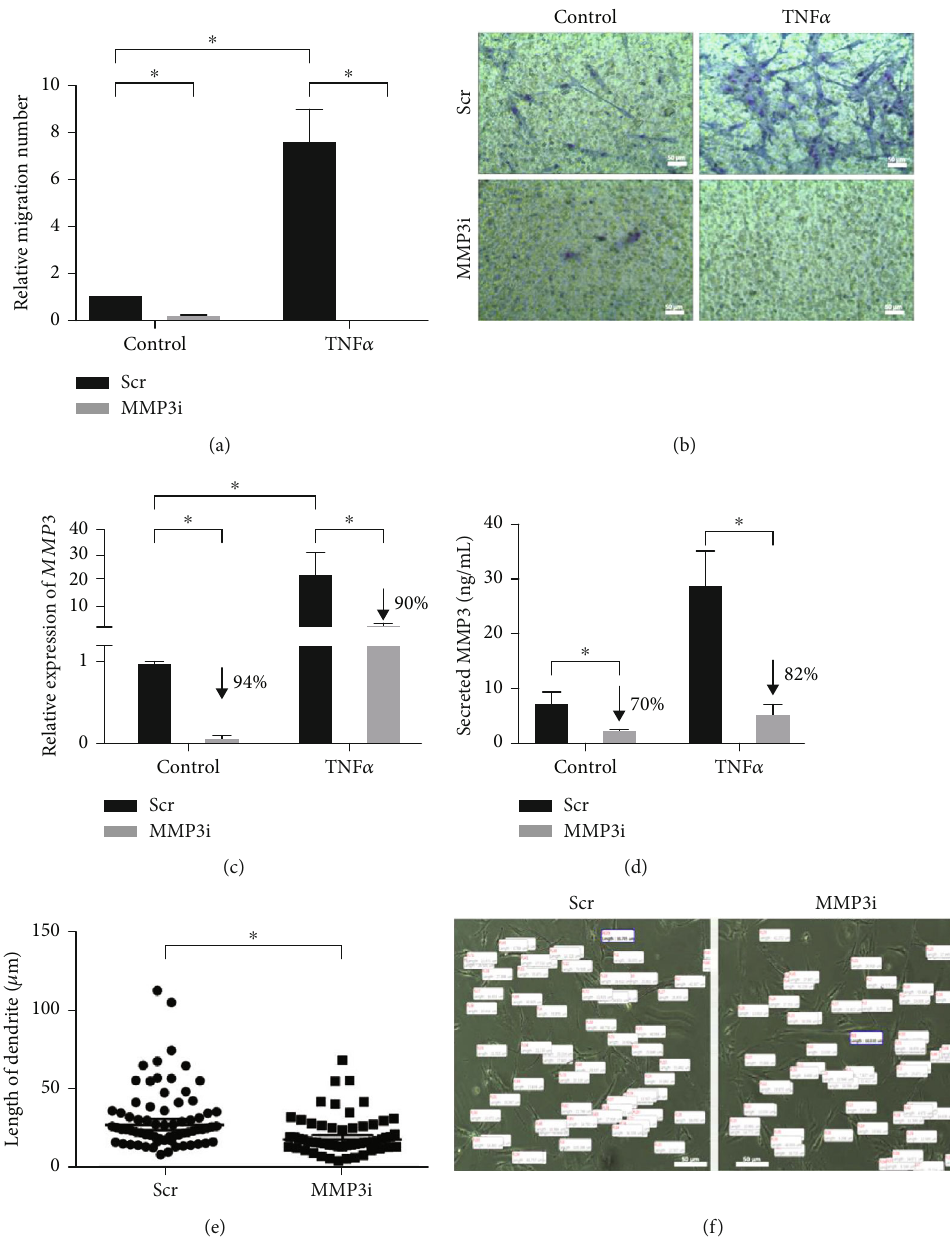
Figure 3: FDCLC migration is induced by TNF α and is dependent on MMP3 expression. FDCLCs were transfected with either the MMP3 siRNA (MMP3i) or a scrambled-RNA-negative control (Scr). The cells were then treated with TNF α , and a migration assay was performed using A Matrigel-coated Transwell system. (a) Disruption of MMP3 expression drastically suppresses TNF α -induced FDCLC migration. The Transwell membranes were stained with hematoxylin and eosin, and the migrated cells that attached to the undersurface of the membrane were counted in 3 di ff erent fi elds under a microscope. Representative images of migrated FDCLCs are shown in (b). MMP3 siRNA signi fi cantly reduced MMP3 mRNA expression (c) and MMP3 secretion (d) in both control and TNF α -treated FDCLCs. (e) The length of FDCLC dendrites. MMP3i showed 34% reduction of the length of the dendrites. (f) Representative images of the FDCLC dendrites. Data shown are the mean values with SD of three independent biological replicates; ∗ p < 0 : 05